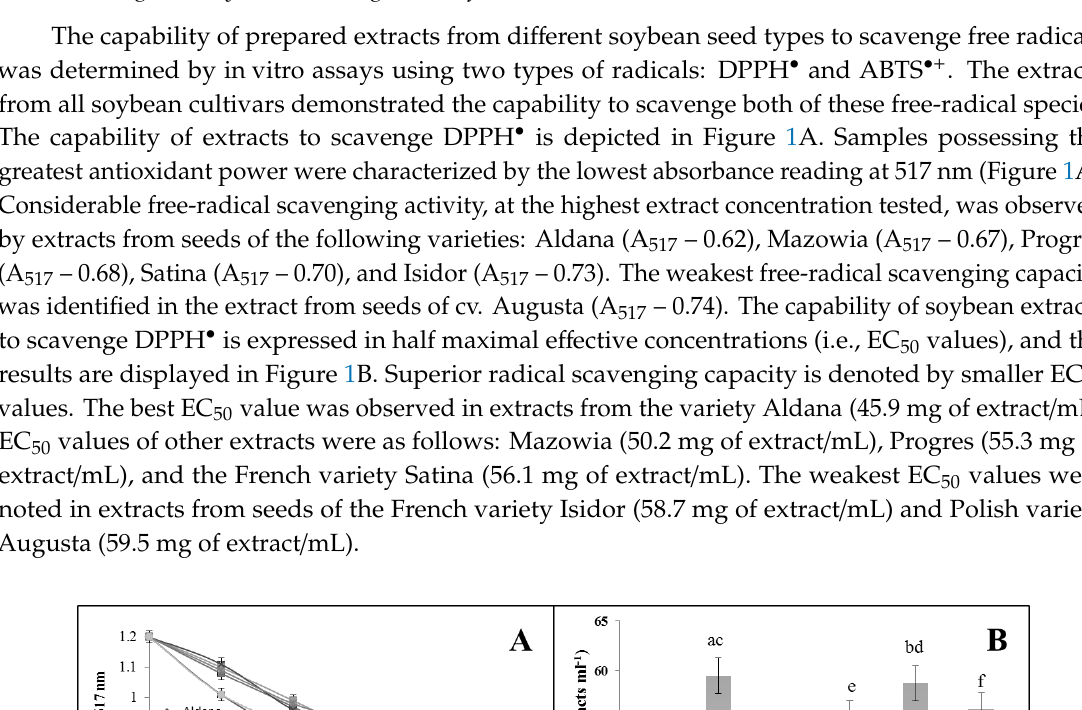
Means with the different letters (a,b,c,d,e) in the column are significantly different ( p < 0.05). Data represent the mean ± SD of four replicates Varieties from France are marked with an asterisk (*), the other varieties come from Poland.